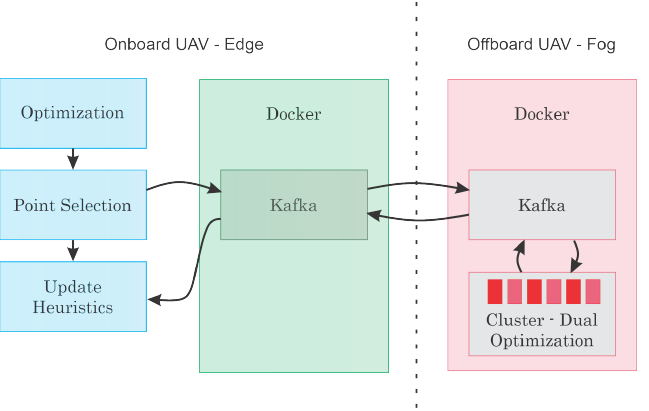
Figure 19. Edge-fog communication scheme simulation.